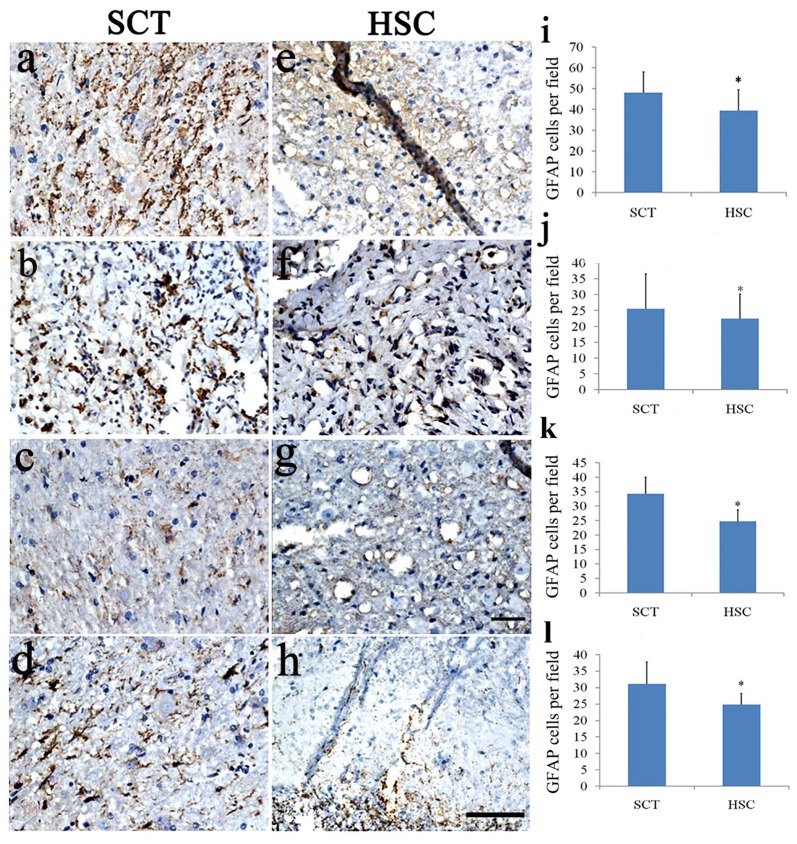
HSC transplantation decreased the number of astrocytes. SCT greatly increased the number of GFAP+ cells in the rostral, scar and caudal sites of the transected cord (A–D). While HSCs transplantation effectively impressed the number of astrocytes in these segments (E–H). Histogram showed that the number of astrocytes in HSC transplanted group was lower than that of SCT one (I–L). (A,E,I) Scar center; (B,F,J) Posterior Funiculus of rostral scar; (C,G,K) gray matter of rostral scar; (D,H,I) Dorsal horn of caudal scar. Data are presented as the mean ± SD (n = 7). Student’s t test was used to analyze the data. Data in the sham group were not shown. *P < 0.05 vs. SCT. Bar = 50 μm.